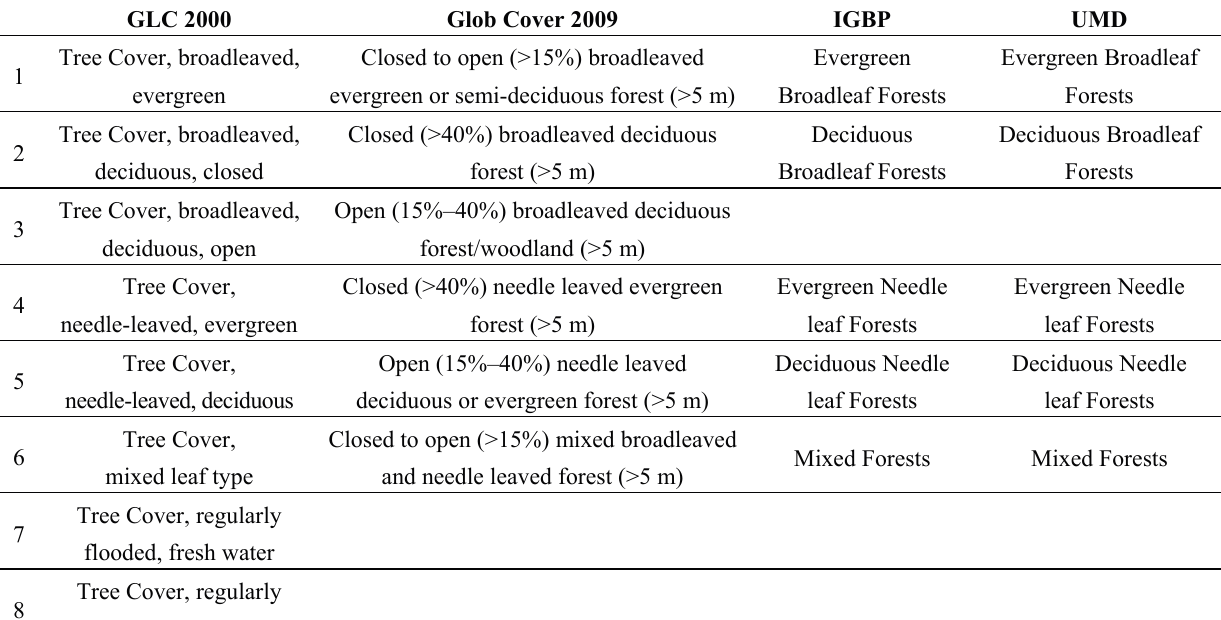
Table 1. Different Global Land Cover legends, their class names and